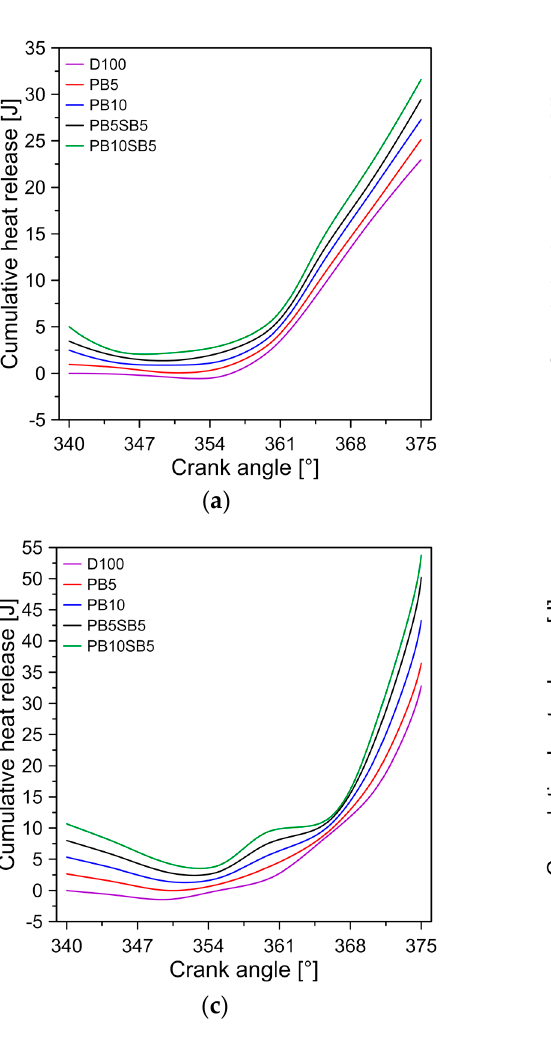
Figure 6. Influence of fuel on heat release rate for ( a ) mode A, ( b ) mode B, ( c ) mode C, and ( d ) mode D.